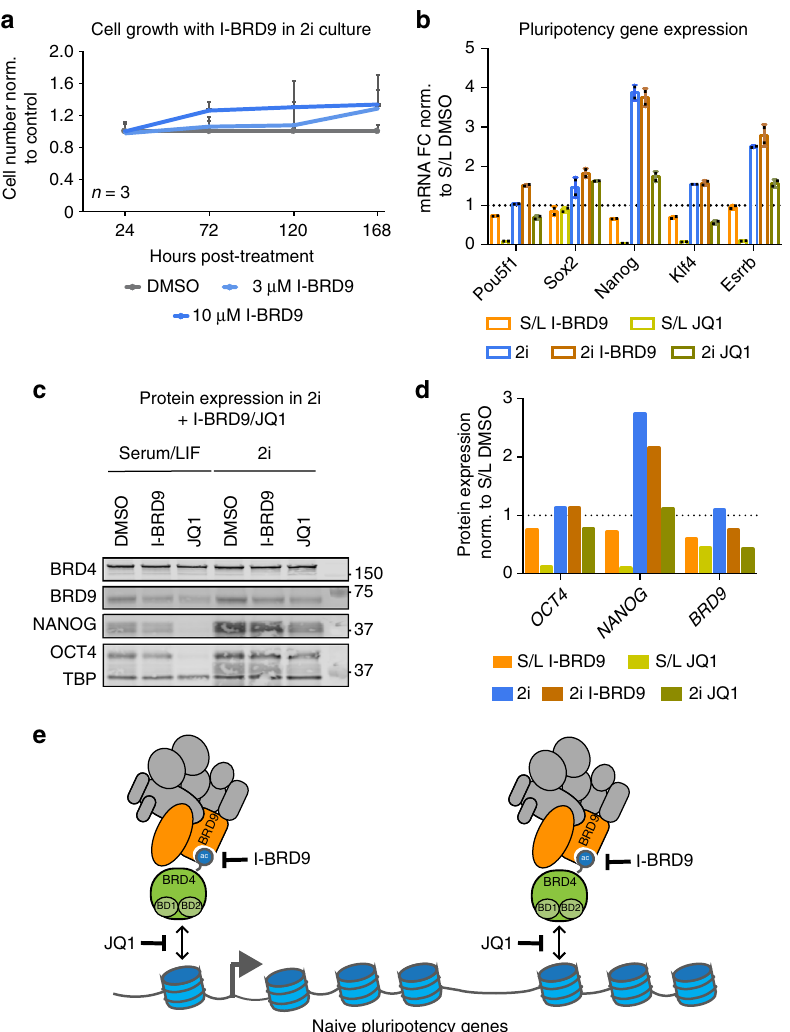
Fig. 8 BRD9 is dispensable for regulating the naive pluripotency network in 2i. a Time course experiment assessing mouse ES cell number cultured in 2i conditions (MEK inhibitor PD0325901 and GSK3 inhibitor CHIR99021), after treatment with DMSO or I-BRD9 at either 3 or 10 µ M. Error bars represent one standard deviation from the mean of three biological replicates. b Bar graph showing the fold change in pluripotency gene expression after 72 h of treatment with I-BRD9 or JQ1 of ESCs cultured in serum/LIF (S/L) or 2i. Mean of two technical replicates; error bars represent one standard deviation from the mean. Source data are provided as a Source Data fi le. c Immunoblotting analysis of ESC nuclear lysates after 72 h of treatment with I-BRD9 or JQ1 of ESCs cultured in S/L or 2i. Molecular weights from ladders are indicated. Source data are provided as a Source Data fi le. d Quanti fi cation of the indicated proteins in c , normalized to TATA-binding protein (TBP) loading control then normalized to values in S/L DMSO. Dotted line is y = 1, which represents S/L DMSO. e Model of BRD4-mediated recruitment of BRD9/GBAF to sites annotated to naive pluripotency